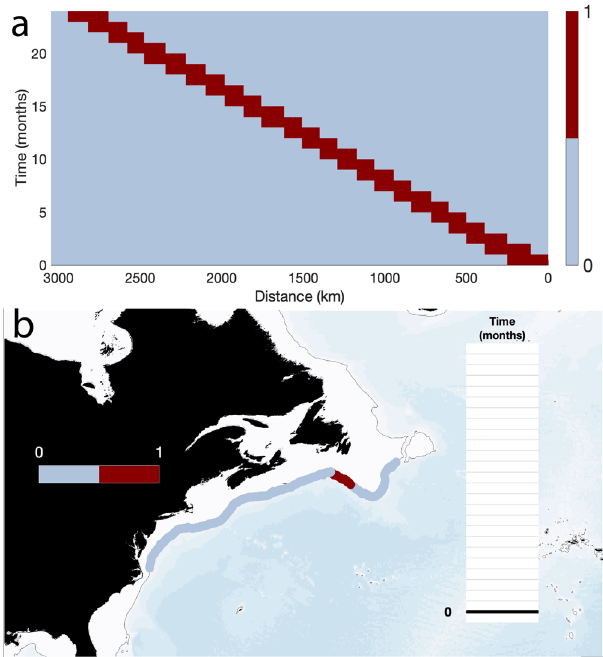
Fig. 1 Static image vs. animated map. a Hövmoller diagram, with distance (km) on the horizontal axis and time (months) on the vertical axis. The red shades indicate the propagation of a signal in space and time, from the bottom right to the top left corner. b Map of the Northwest Atlantic showing a different representation of the Hovmöller diagram. The red signal propagates along the blue line as a function of time. The animated map is available as Supplementary Video 1. For simpli fi cation, the data used here is not that originally used in the